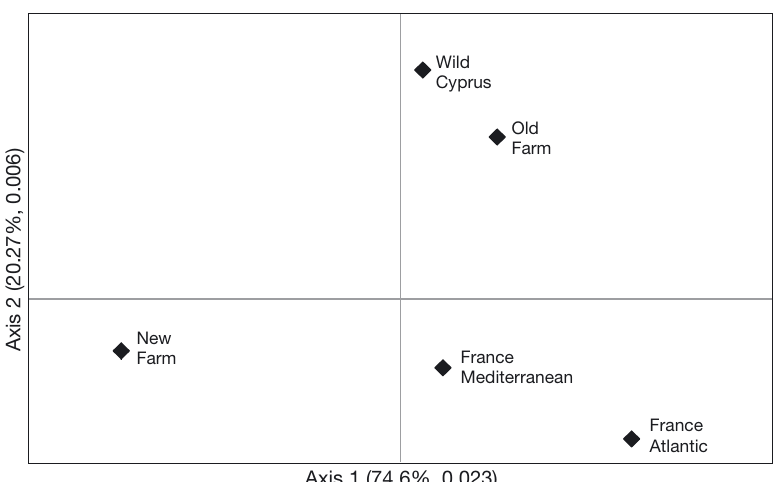
Fig. 2. Principal coordinate analysis based on the standardized covariance of Nei (1978) unbiased genetic distance between the farm populations and popu- lations from Atlantic, West Mediterranean and East Mediterranean (wild Cyprus). A total of 17−25 samples were used per population. Axis label in- cludes percentage of variation explained by axis and the axis Eigenvalue